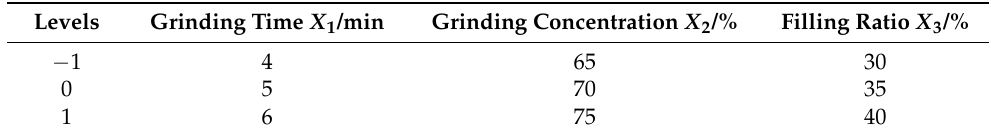
Table 12. Design of factors and levels of response surface method.